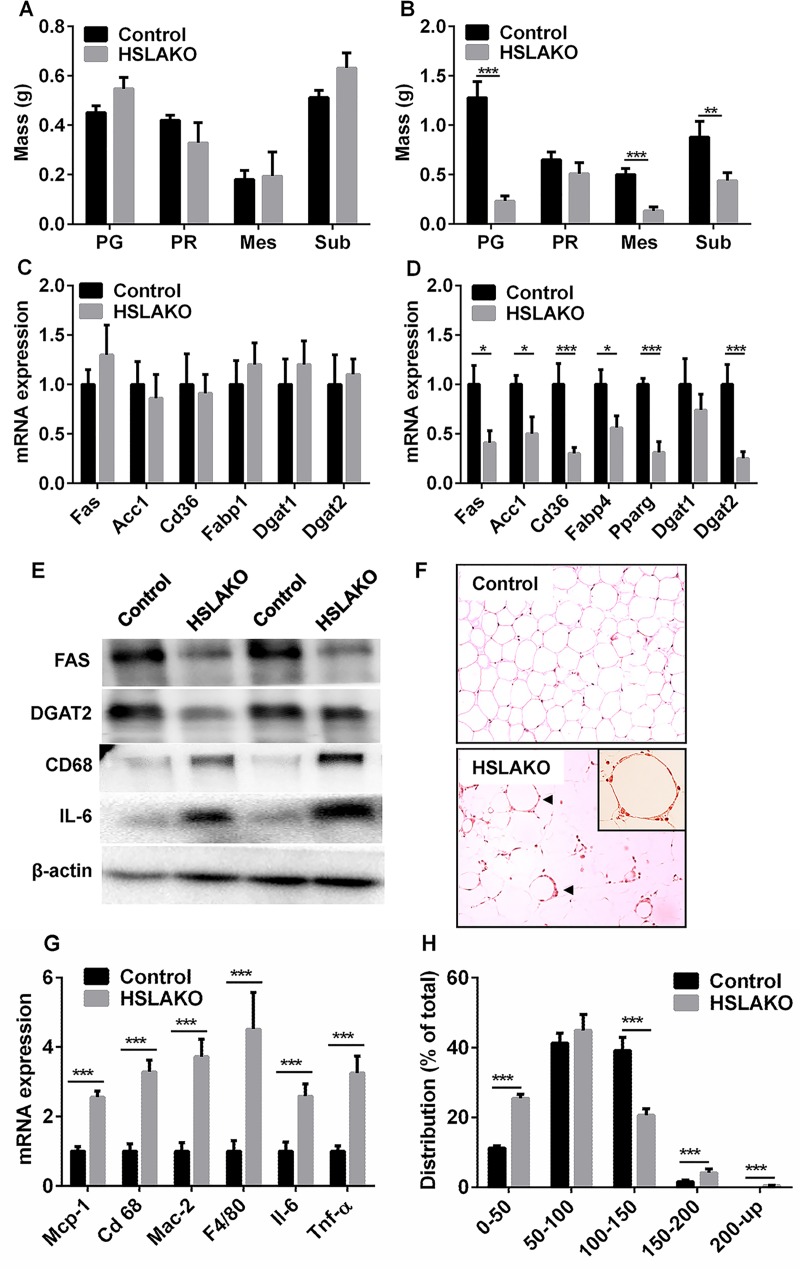
Lipodystrophy and macrophage infiltration of white adipose tissue of HSLAKO mice.A. masses of different fat depots at 3 months. B. masses of different fat depots at 8 months. Mice were fasted for 5 hours (n = 6). PG, perigonadal; PR, perirenal; Mes, mesenteric; Sub, subcutaneous fat. C. 3-month-old mice and D. 8-month-old mice adipose expression of transcripts related to TG metabolism. Fas, fatty acid synthase; Acc1, acetyl-CoA carboxylase 1; Cd36, cluster of differentiation 36, (a transporter for fatty acids); Fabp4, fatty acid binding protein 4; Ppar-γ, peroxisome proliferator-activated receptor gamma; Dgat1, diacylglycerol O-acyltransferase 1; Dgat2, diacylglycerol O-acyltransferase 2. Mice fasted for 5 hours were used (n = 6). E. Protein expression in adipose tissue. Western blots of the indicated proteins, 8-month-old mice adipose tissue. F. H&E staining of white adipose tissue, showing the high prevalence of crown-like structures (arrows), X100; Inset, enlarged image of a crown-like structure, > 200; G. markers of macrophage and of inflammation in adipose tissue (n = 6); H. distribution of adipocyte diameter. 8-month-old mice fasted for 5 hours were used.